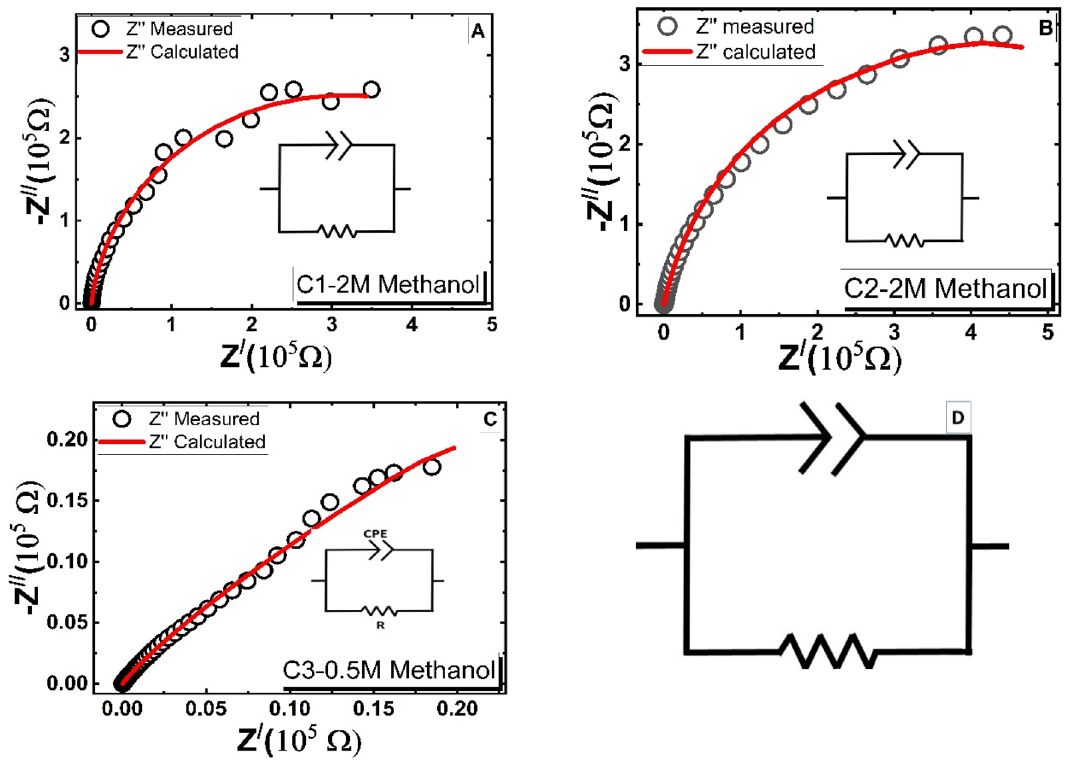
Figure 13. Cole–Cole plot of ( A ) C1, ( B ) C2, and ( C ) C3 investigated samples, and ( D ) equivalent circuit obtained by EIS